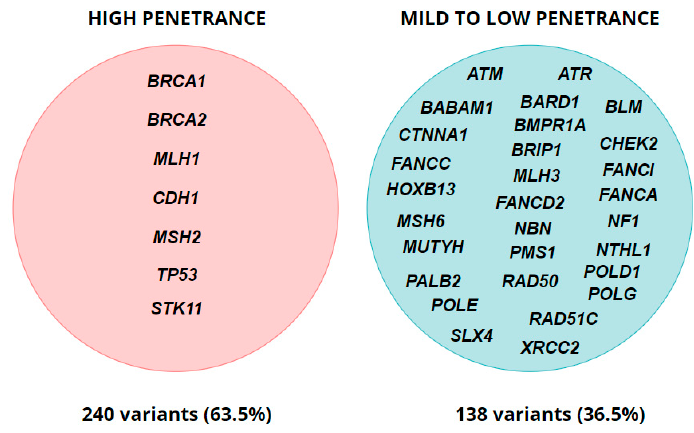
Figure 1. Penetrance of genes with identified P/LP variants (for monoallelic alterations).